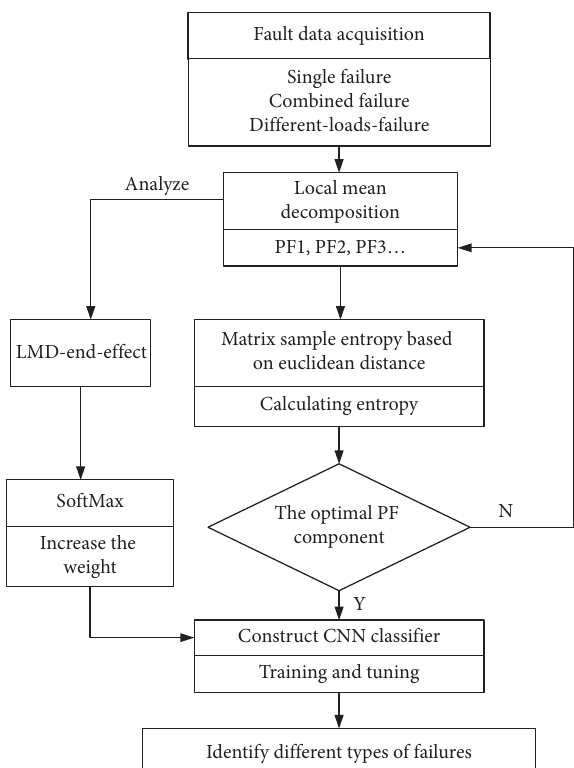
Figure 15: The flow chart of final